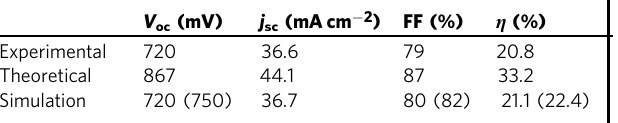
Table 1 Photovoltaic parameters from experiment and simulations.